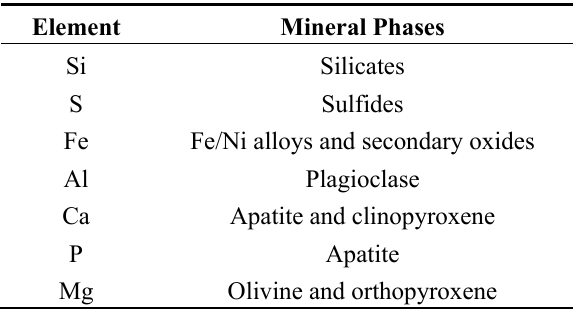
Table 2. List of the thin sections studied and of the institutions that provided the